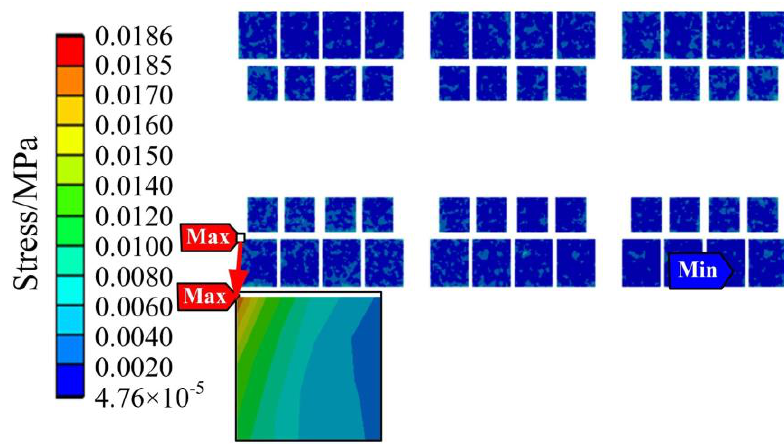
Figure 16. The stress of chip solder layer under the first order mode.